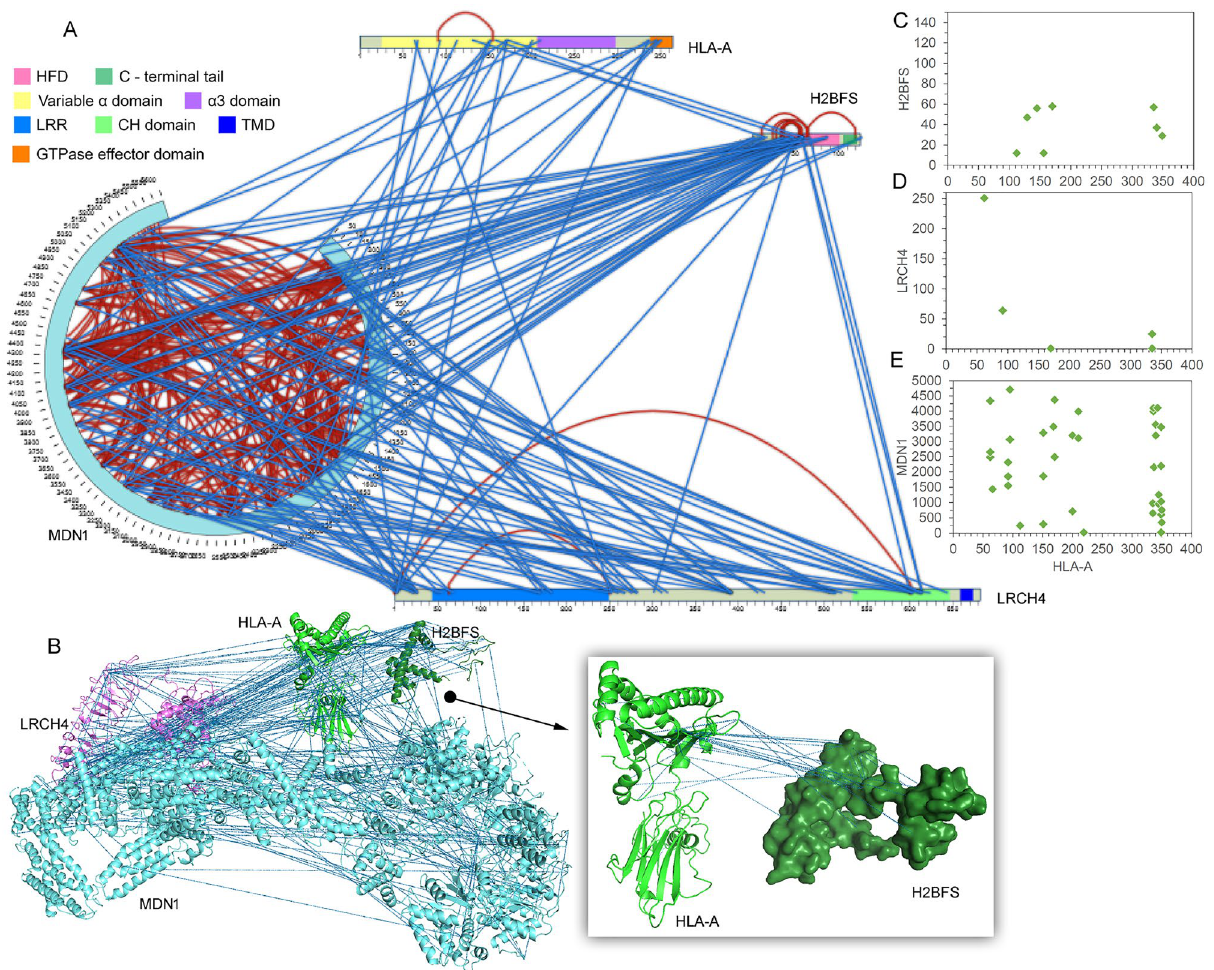
Figure 6. The IFNα induced interaction network of HLA-A with H2B (H2BFS), MDN1, and LRCH4. (A) The intramolecular (red) and intermolecular (blue) cross-links represented in the 2D interactive map (generated in SIM-XL program 29 ), MDN1 is presented in the circular view. The cross-link score cut-off was set to 3.5. Domains of different identities are labeled with their respective colors 32 : H2B (histone; 2–102), MHC-I (MHC_1; 25–203, C1-set; 210–290, and MHC_I_C; 337–364), and LRCH4 (LRR_8 (68–126), LRR_8 (137– 194), and CH (535–641)). (B) Inter-link between proteins displayed over the H2B, HLA-A, LRCH4, and MDN1 protein structures in the PyMOL program. These structures were modeled using the Phyre2 server (http:// www. sbg. bio. ic. ac. uk/ phyre2), and the template structures for the proteins H2B, HLA-A, LRCH4, and MDN1 were 1kx5 52 , 1kj3 49 , 6hlu 62 , and 6i26 65 , respectively. Dot plots showing the interaction sites K or S of HLA-A with H2B (C) , LRCH4 (D) , and MDN1 (E) . For the plots, the cross-link score cut-off was set to